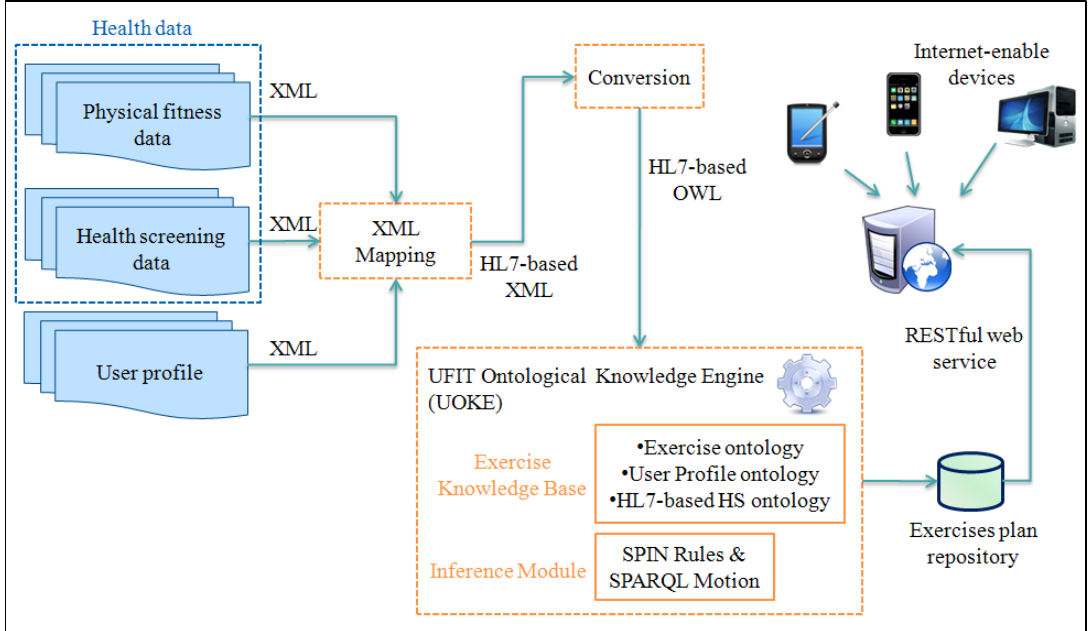
Figure 6. UFIT logical